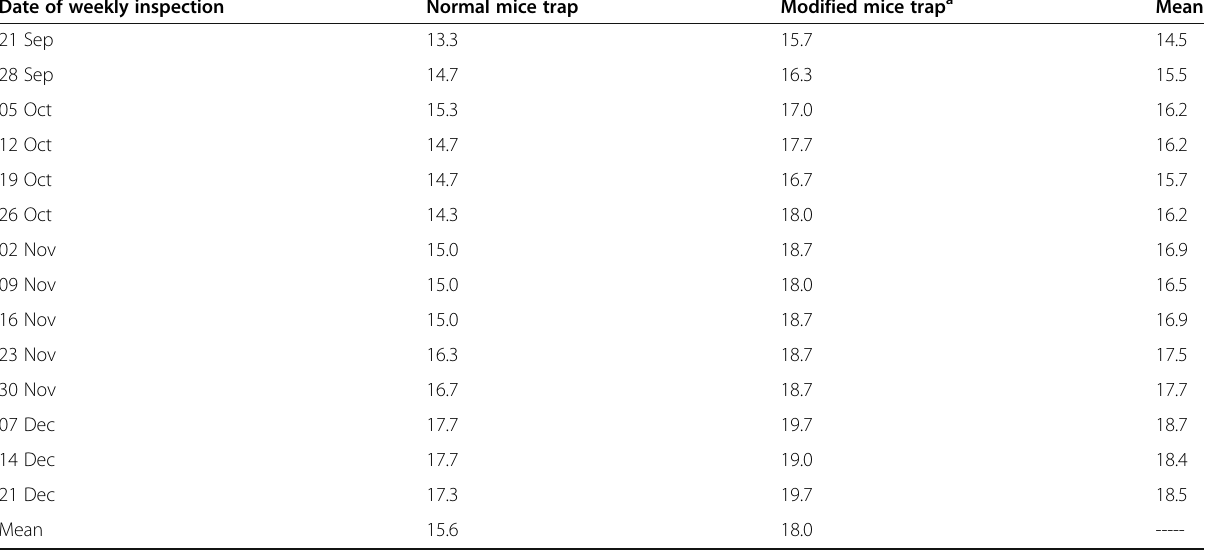
Table 3 Average numbers of Varroa mite fallen on adhesive sheets during September 21 to December 21 of 2019 under bee house conditions at Dakahlia governorate,